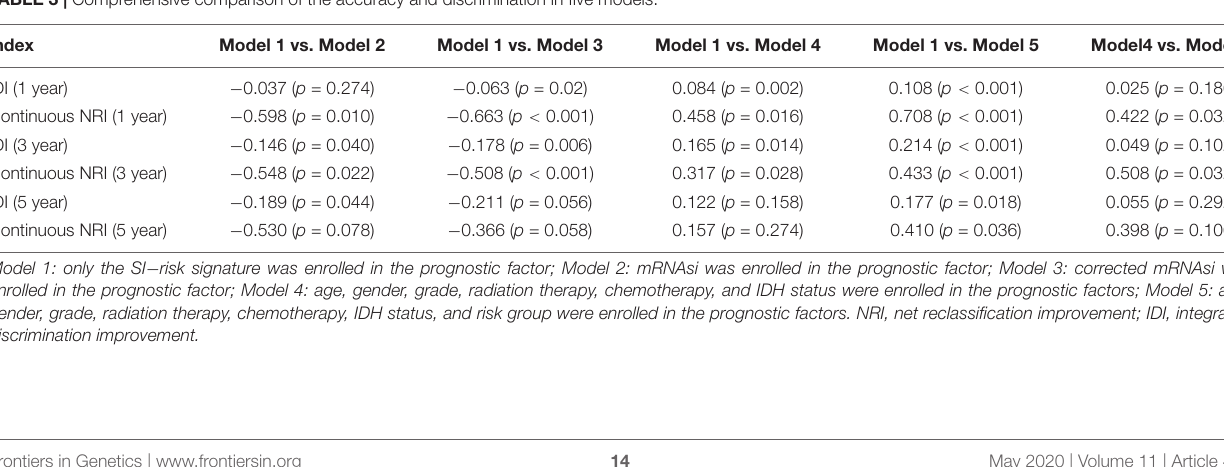
TABLE 3 | Comprehensive comparison of the accuracy and discrimination in five